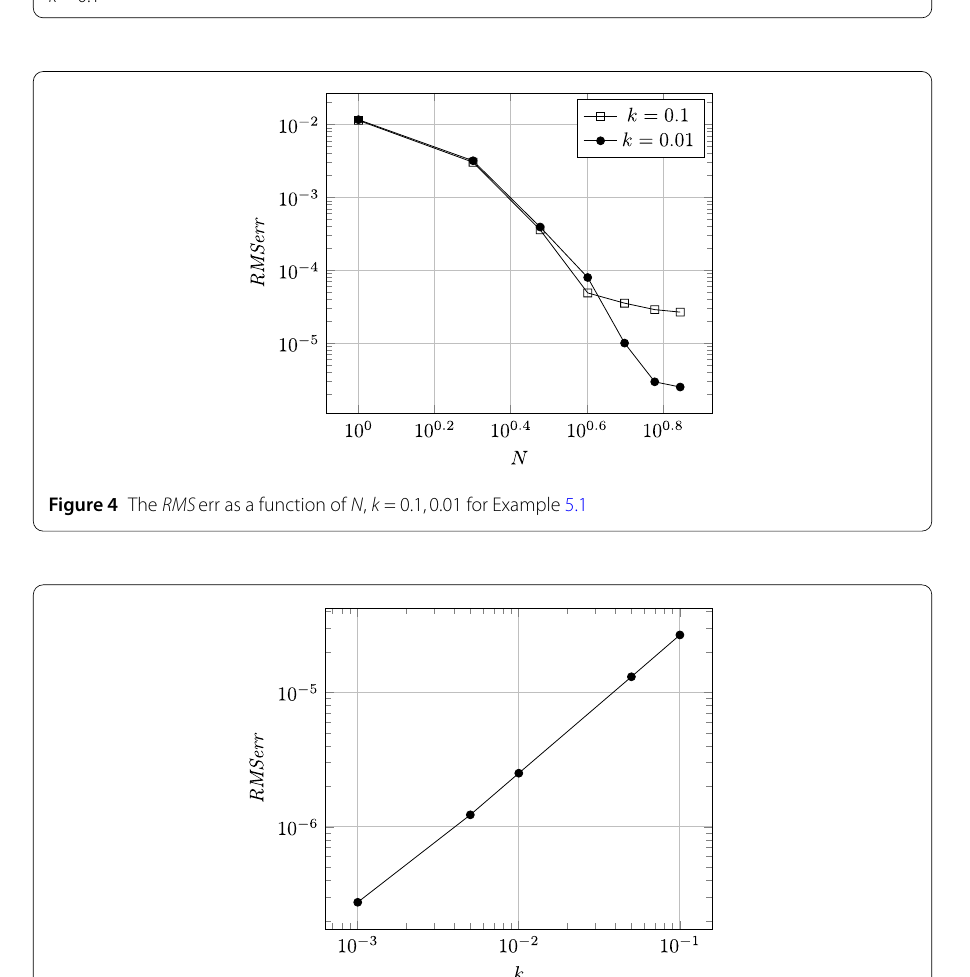
In Fig. 5, we report the quantity RMS err for k ranging from 0.001 to 0.1 and fixed N = 7 and N e =